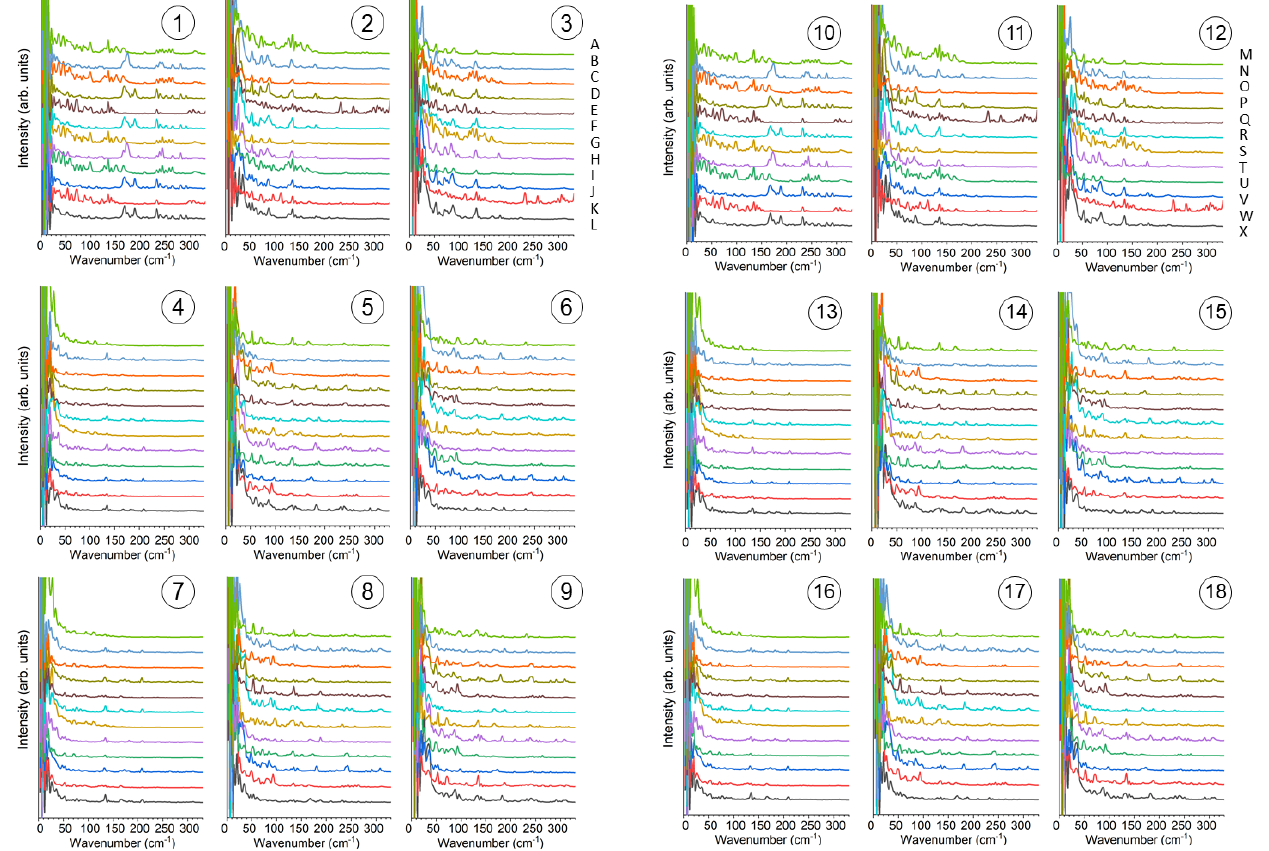
Figure 7. Simulated local vibrational feature of “valence electron density” of PEEK obtained from Fourier transform of approximate local valence electron density calculated from the atomic trajectory in MD. The curves in each figure from top side to bottom side correspond to the calculated points in each column from top side to bottom side in c direction. The positions of calculated points can be found through a circled number and an uppercase letter as we introduced in Figure 6.